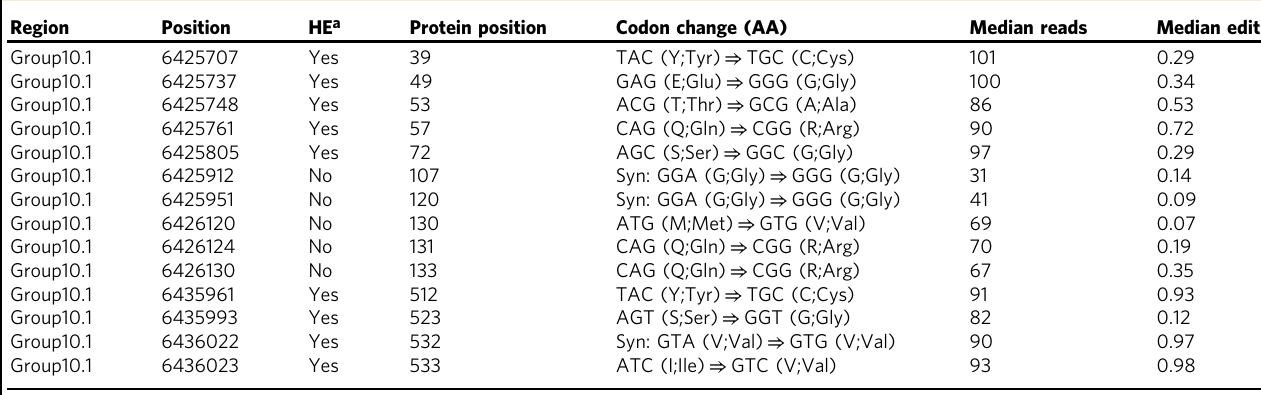
Table 1 Putative RNA editing sites on the bumblebee Shab potassium channel protein Region Position HE a Protein position Codon change (AA) Median reads Median edit Group10.1